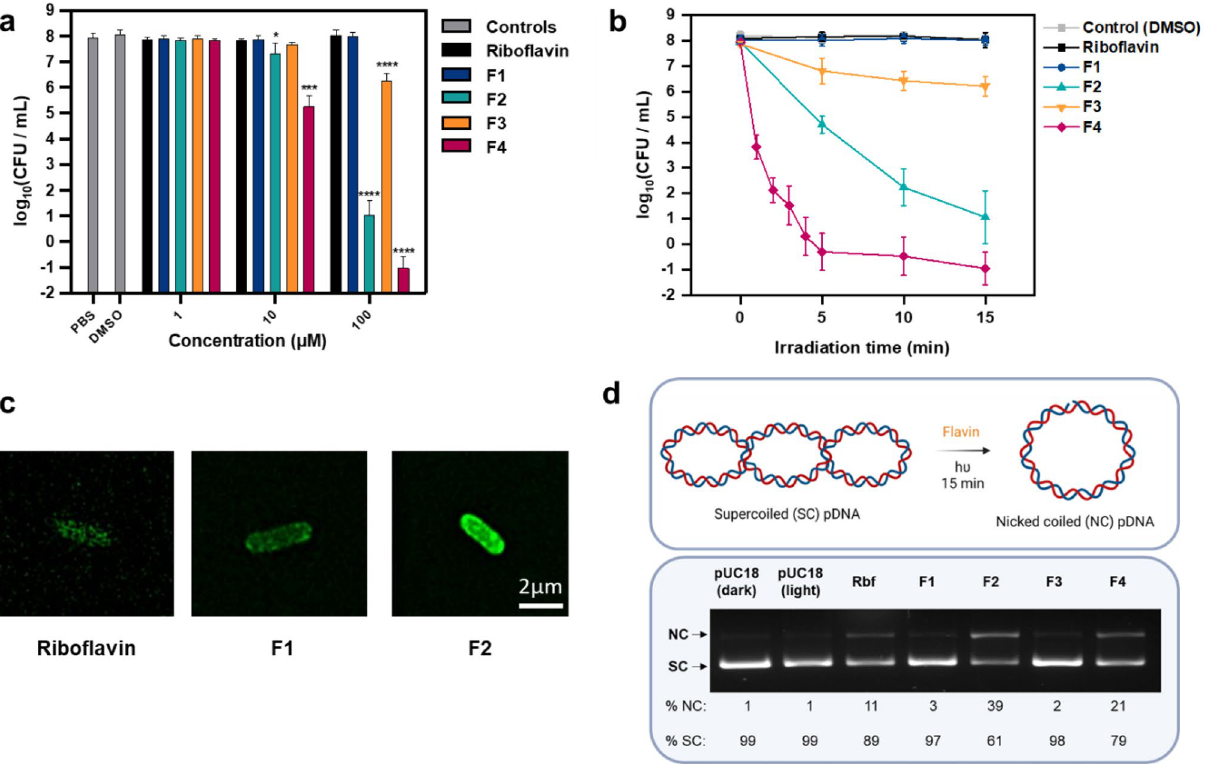
Figure 3. Photodynamic inactivation of E. coli . ( a ) Photodynamic inactivation of E. coli BL21(DE3) incubated with various concentrations of flavins irradiated with white LED light (1 × 10 5 lx, 35 mW/cm 2 ) for 15 min in PBS containing 0.5% DMSO. Data are expressed as the mean ± SD of three biological replicates. Significance levels are defined compared to PBS control as the following: * for p ≤ 0.05, ** for p ≤ 0.01, *** for p < 0.001, and **** for p < 0.0001 ( b ) Time course of E. coli inactivation incubated with 100 µM of flavin irradiated with white LED light (1 × 10 5 lx, 35 mW/cm 2 ) for 15 min in PBS containing 0.5% DMSO. Data are expressed as the mean ± RE of three biological replicates. ( c ) SIM images depicting the localisation of flavins in E. coli after incubation with 100 µM flavin. ( d ) Agarose gel electrophoresis of pDNA (pUC18) following incubation with 10 µM flavin irradiated with white LED light (1 × 10 5 lx, 35 mW/cm 2 ) for 15 min in PBS containing 0.1% DMSO. Rbf = Riboflavin. Uncropped gels can be found in ESI (Figure